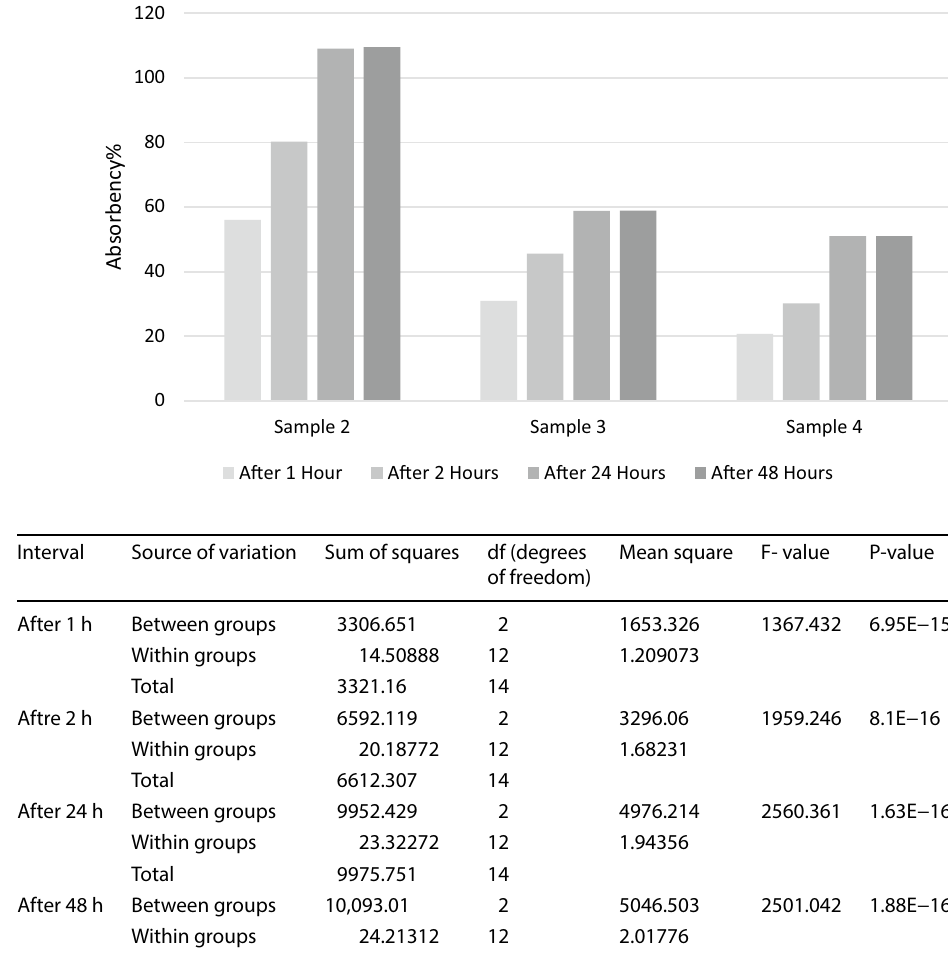
Fig. 2 Water absorbency of different samples. [Sample 2 was made using Starch with 2% Sodium Hydroxide and